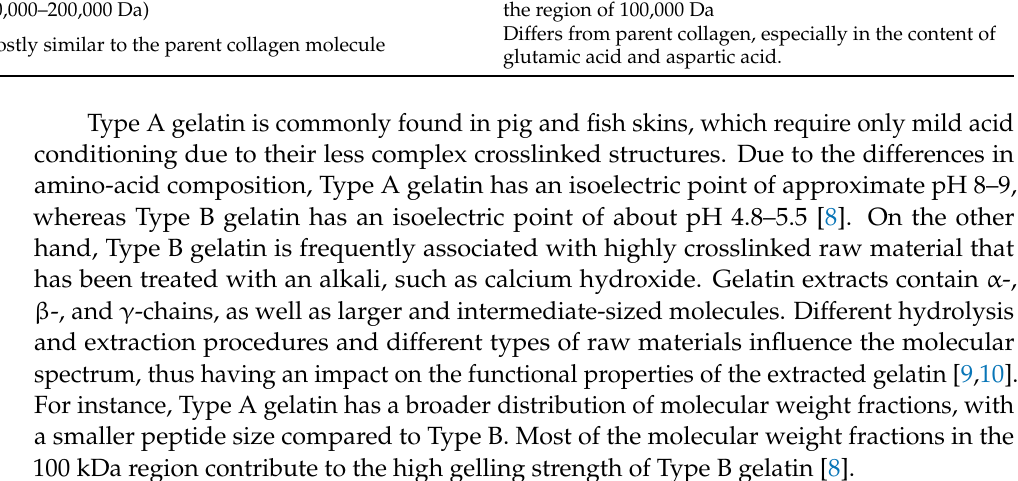
Table 1. Types of gelatin.